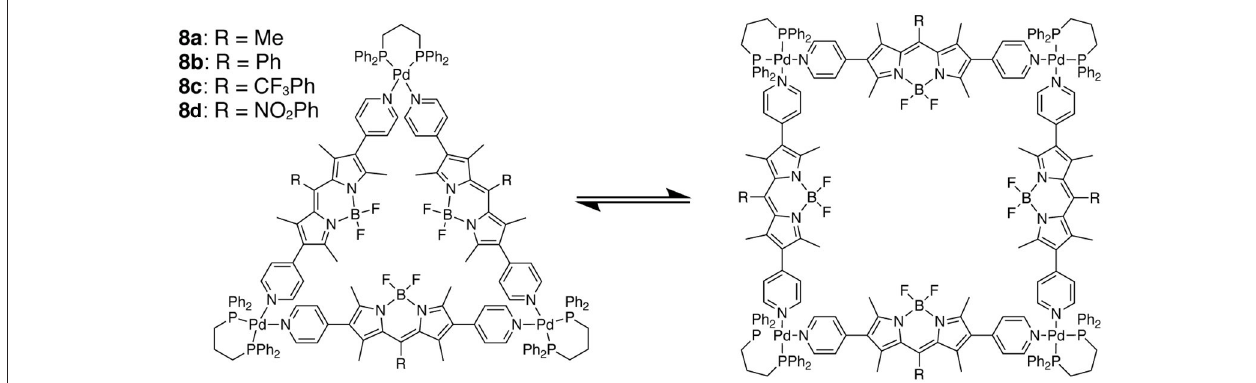
FIGURE 5 | Dynamic equilibrium between the triangular and square forms of macrocycles 8a – 8d .